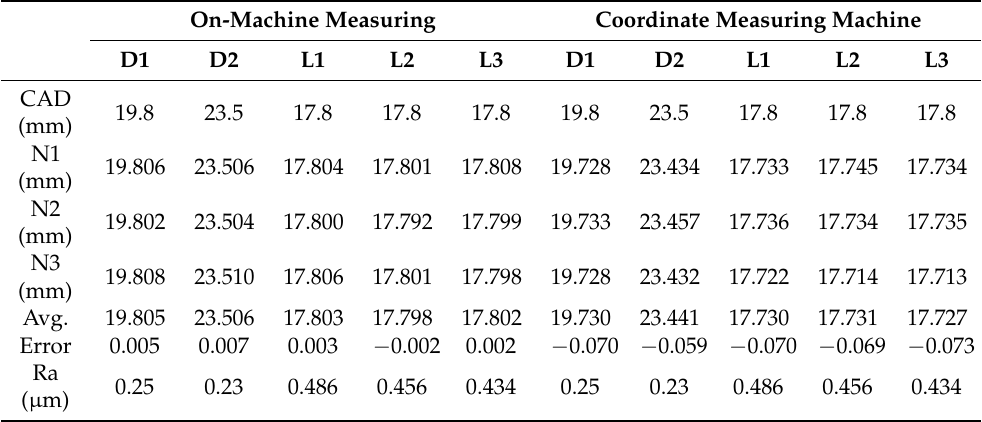
Table 3. Comparison table of measurement between OMM (before probe calibration) and CMM. On-Machine